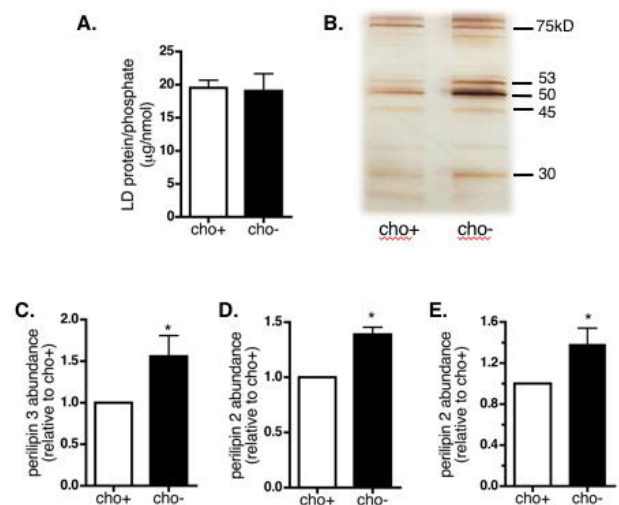
Figure 7. LD protein composition in choline-deficient cells. LDs were isolated from NIH 3T3 ( A – D ) or AML12 ( E ) cells grown in oleate-supplemented media with (cho+) or without (cho − ) choline. ( A ) Total levels of protein in LD fractions are shown relative to levels of phosphate in those same fractions. Data are averages ± SEM from five independent experiments. ( B ) Equivalent amounts of total proteins from LD fractions were separated by SDS-PAGE and visualized by silver stain. A representative gel is shown. ( C – E ) Levels of perilipin 2 and perilipin 3 in equivalent micrograms of total LD proteins were determined by SDS-PAGE and Western blotting. Data are average values relative to the control ± SEM from five to seven experiments. Asterisks indicate cho- is statistically different than 1.0 (*, p < 0.04, Wilcoxon signed-rank